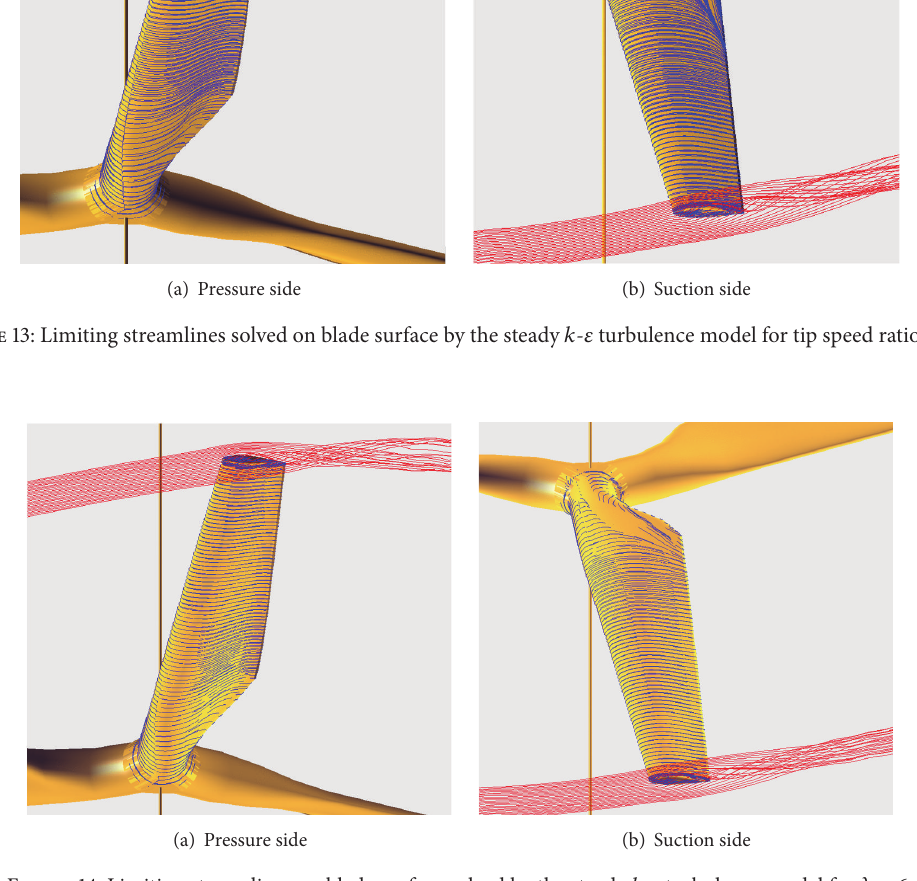
Figure 14: Limiting streamlines on blade surface solved by the steady 𝑘 - 𝜀 turbulence model for 𝜆 = 6 .